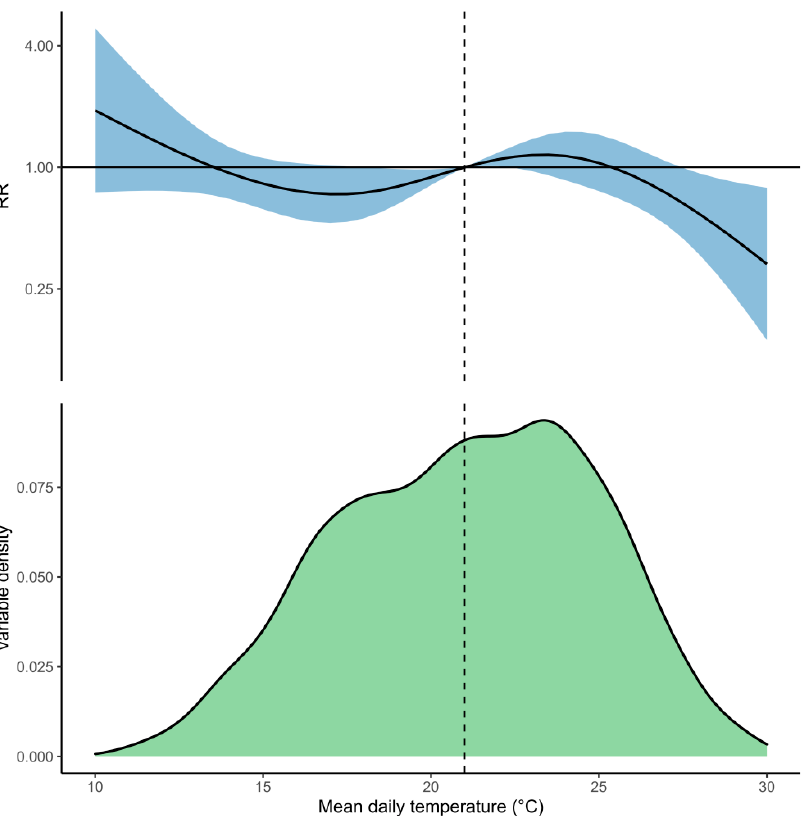
Figure 3. The top panel shows the cumulative association between mean daily temperature and pneumonia hospital admissions across a 21-day lag period. The solid curve is the predicted relative rates (RR), and the shaded region is the 95% confidence interval (CI). The lower panel shows the distribution of mean daily temperature within the infectious Disease Early Warning System (iDEWS) dataset. The median mean daily temperature (21 °C) is indicated by the dashed vertical line and is used as the reference value against which the RR for other temperatures is compared.